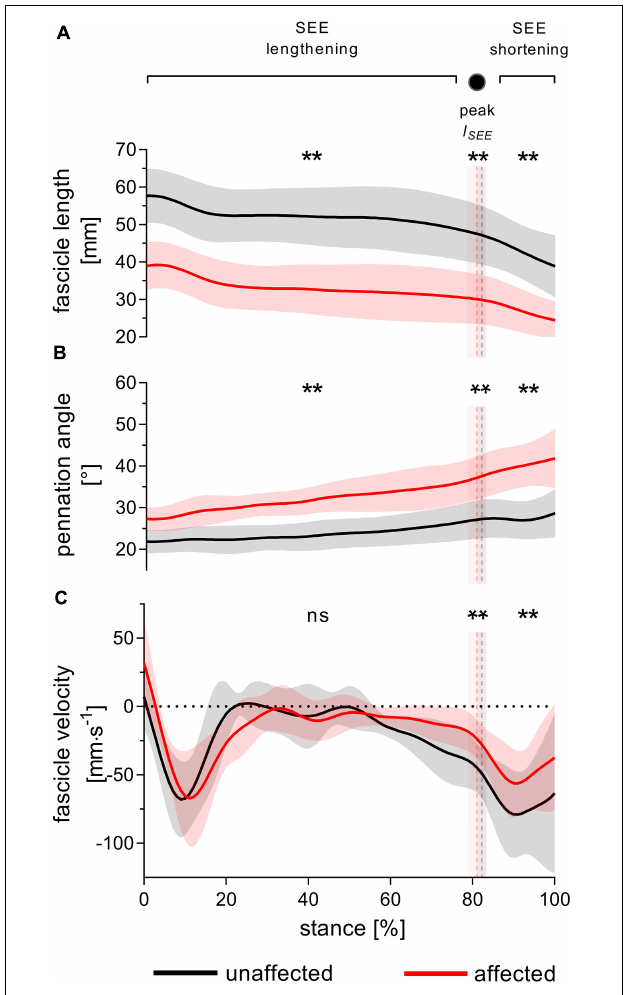
FIGURE 3 | Gastrocnemius medialis operating fascicle length (A) , pennation angle (B) and fascicle velocity (C) during walking stance. The solid black and red lines, with their corresponding shaded areas [standard deviation (SD)], represent mean traces for the unaffected and affected leg, respectively. The dashed vertical lines with their corresponding shaded areas (SD) represent the mean time points of peak series elastic element (SEE) length (peak l SEE ) separating the SEE lengthening and shortening sub-phases. Statistical testing was run on average values during SEE lengthening and shortening sub-phases, and on single data points at peak SEE length. ** p < 0.01, significant side-to-side difference; ns: